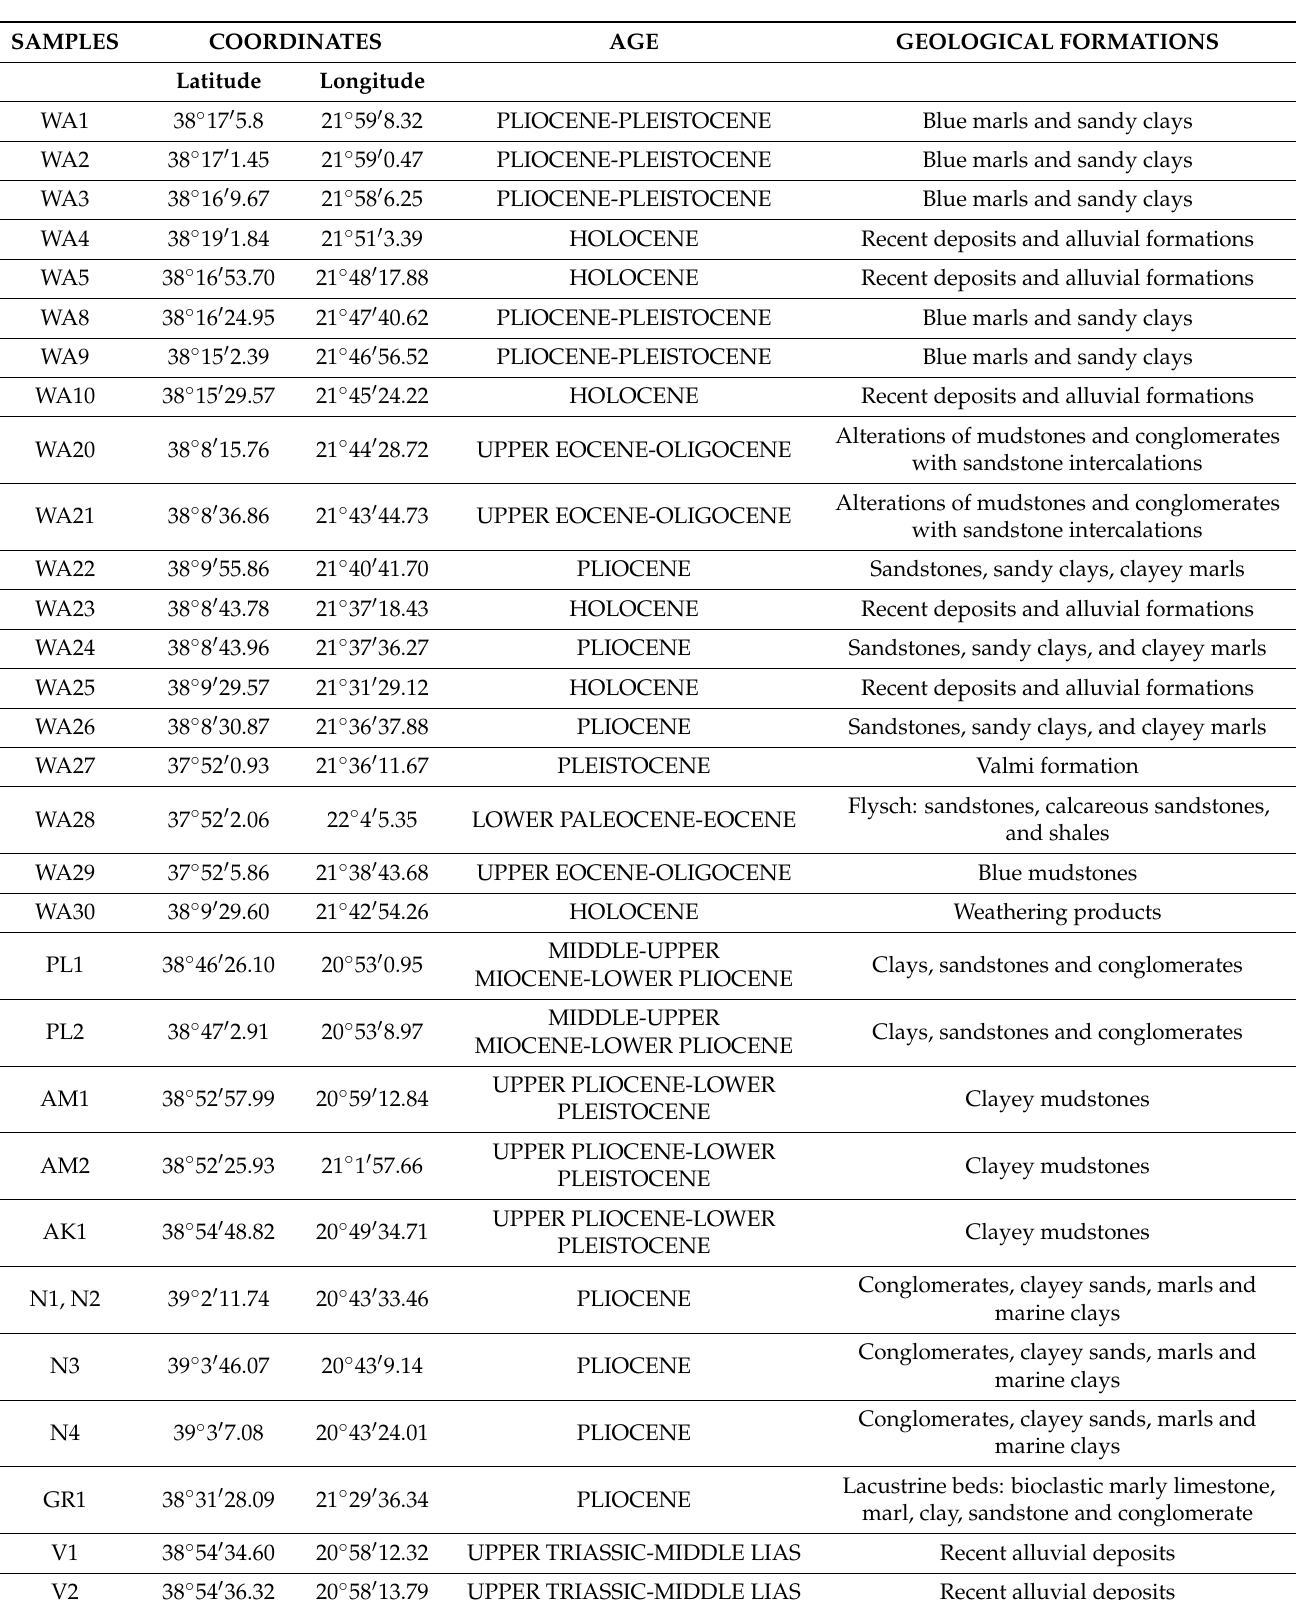
Table 1. List with the studied samples, coordinates of sampling locations, and the respective geological formations. Abbreviations: WA = western Achaean; AK = Aktio; AM =